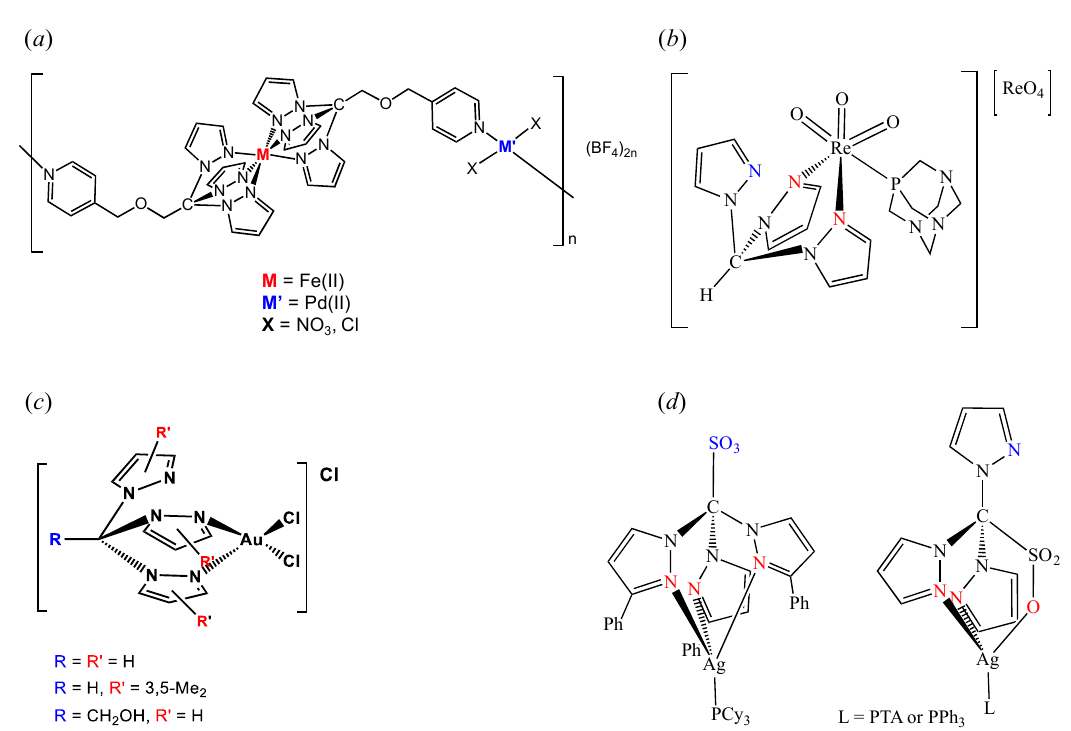
Figure 5. Selected C ‐ homoscorpionate complexes exhibiting: ( a ) tetradentate coordination ability of the scorpionate ligand; ( b ) κ 2 ‐ coordination of the scorpionate ligand at an octahedral geometry; ( c ) κ 2 ‐ coordination of the scorpionate ligand at a square planar geometry ( d ) N 3 ‐ or N 2 O ‐ coordination of the scorpionate ligand.